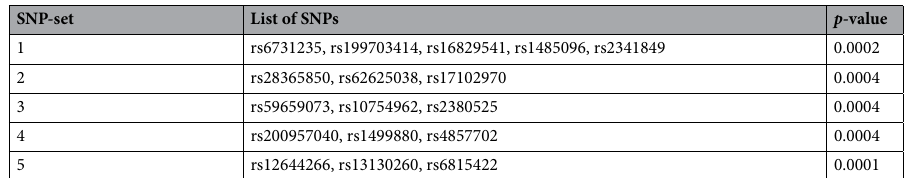
Table 3. SNP-sets obtaining the lowest p -values (excluding those that harbor variants reported by Kim et al. 38 to be significantly associated with HBsAg